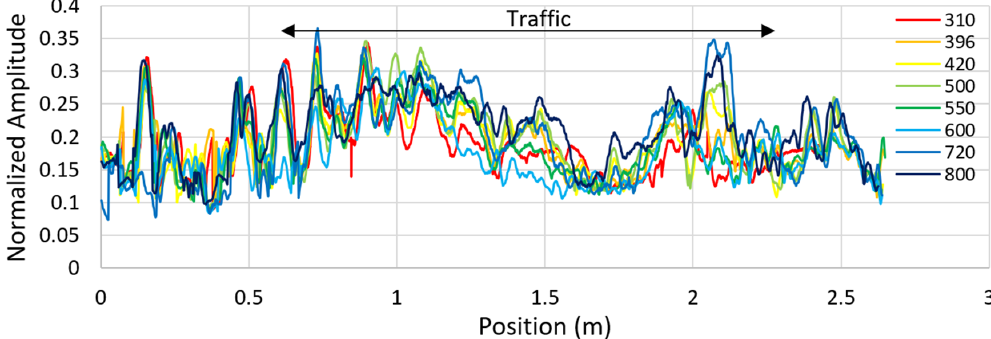
Figure 28. 2.6 GHz Normalized RW amplitudes on tack-coat free (I-3), in the transversal direction vs. K loadings.